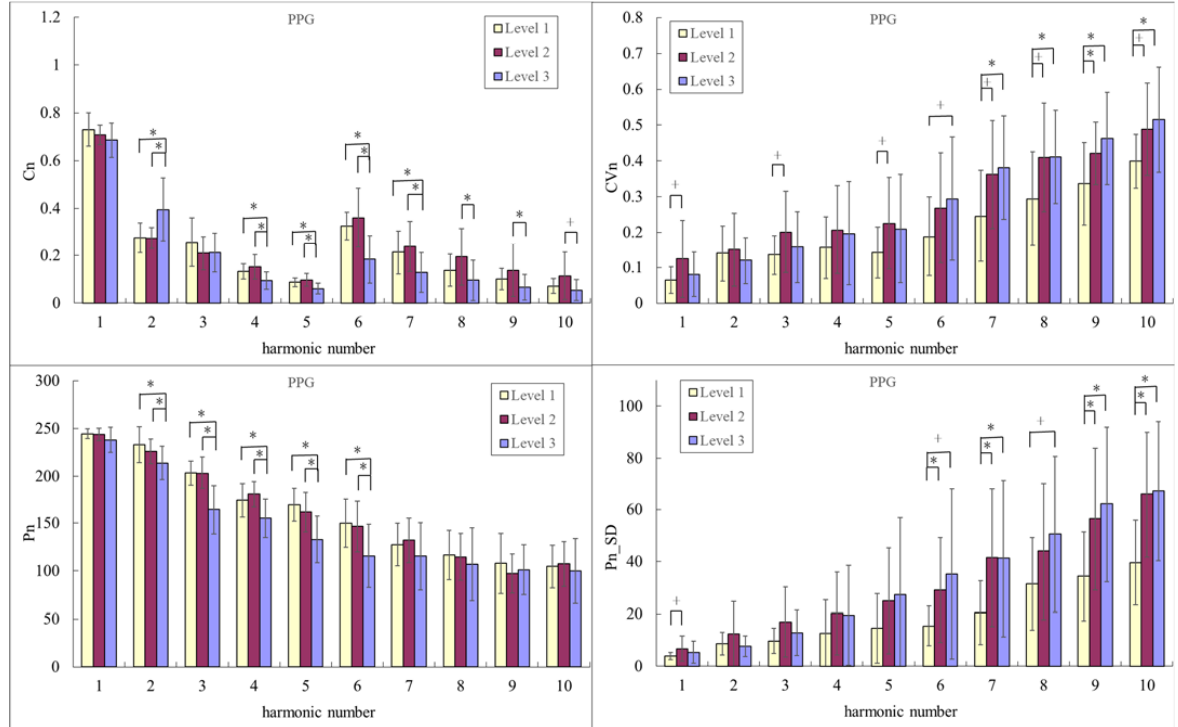
Figure 3. Comparisons of PPG harmonic indices between Level 3, Level 2, and Level 1: C n , CV n , P n , and P n _ SD . Data are mean and SD values. C 5 – C 10 values have been multiplied by 5 to make the di ff erences clearer. “*” indicates p < 0.05; “+” indicates 0.05 < p < 0.1. For C n values, C 2 was signi fi -